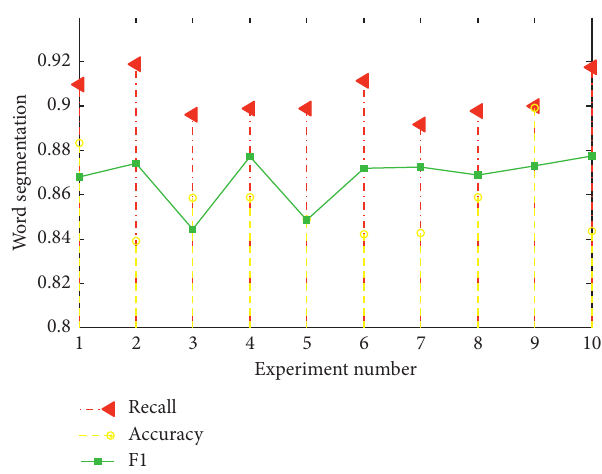
Figure 9: Various word segmentation results of Bird with